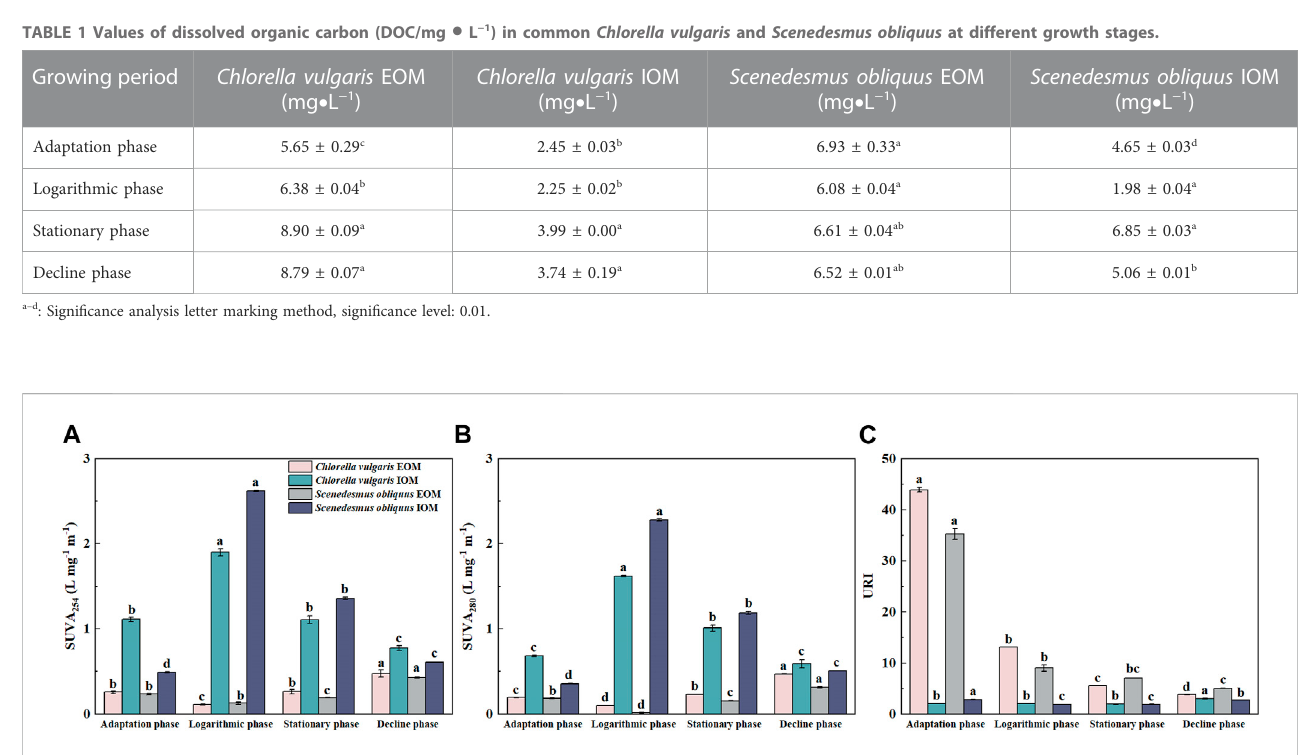
(cid:129) L − 1 ) in common Chlorella vulgaris and Scenedesmus obliquus at different growth stages.